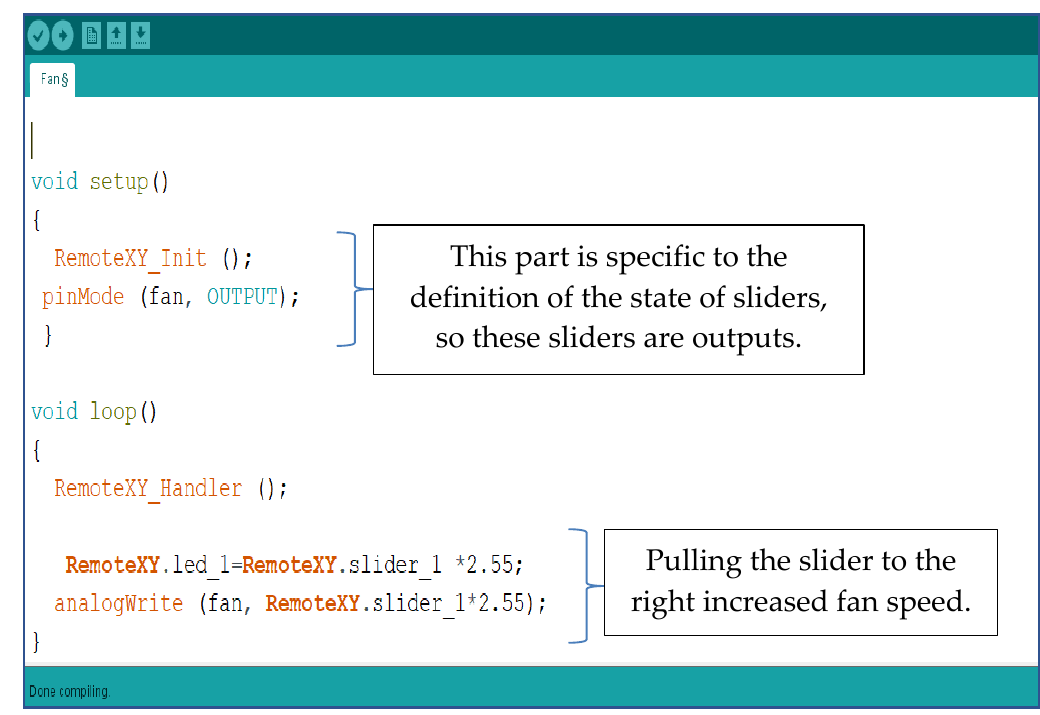
Figure A3. The first part of the executed code used to control the fan speed.